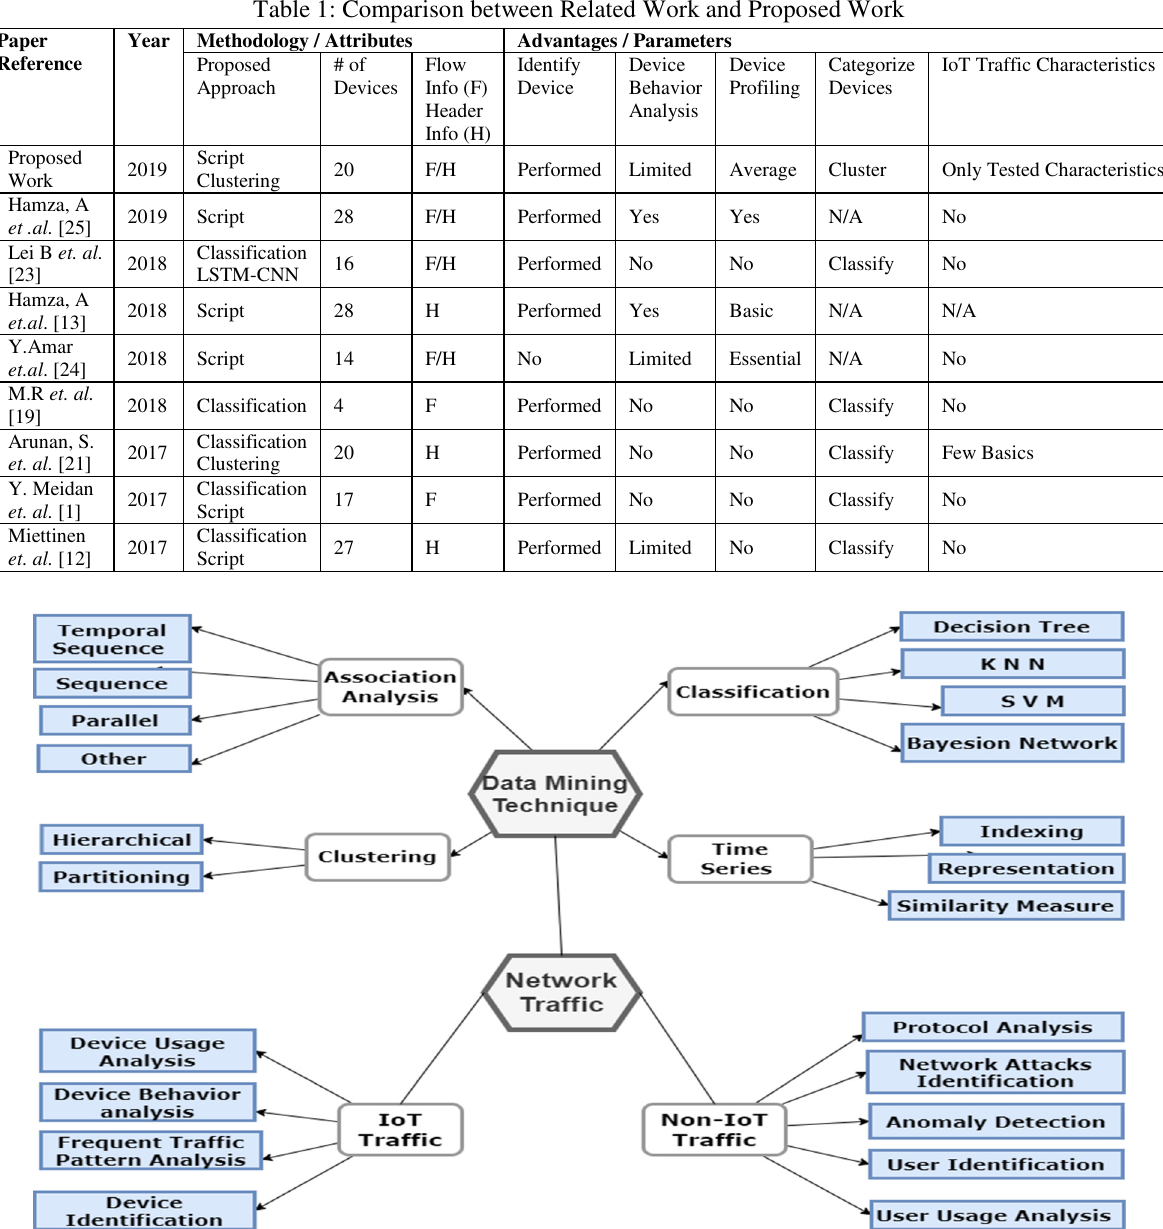
Table 1: Comparison between Related Work and Proposed